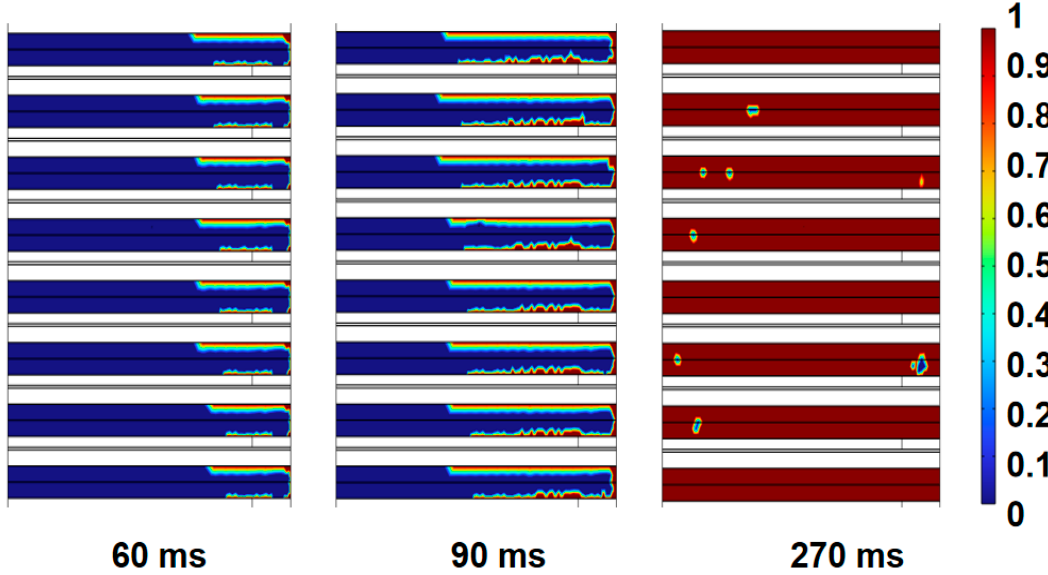
Figure 7. Phase-change cloud diagram of thermal battery at different Figure 7. Phase ‐ change cloud diagram of thermal battery at different times .